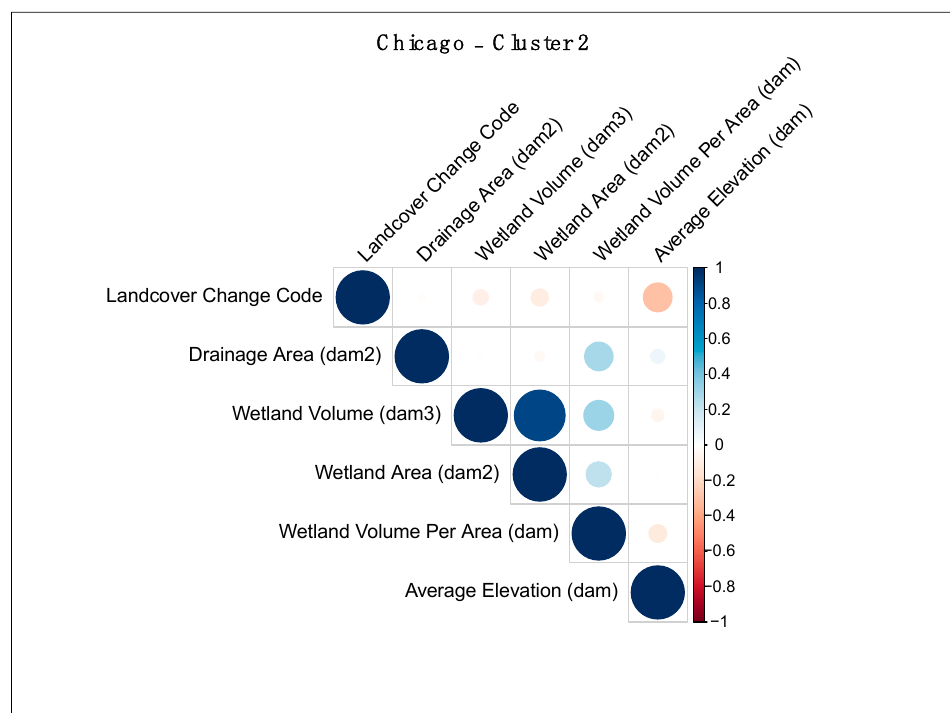
Figure 10. Chicago cluster 2 correlation matrix.